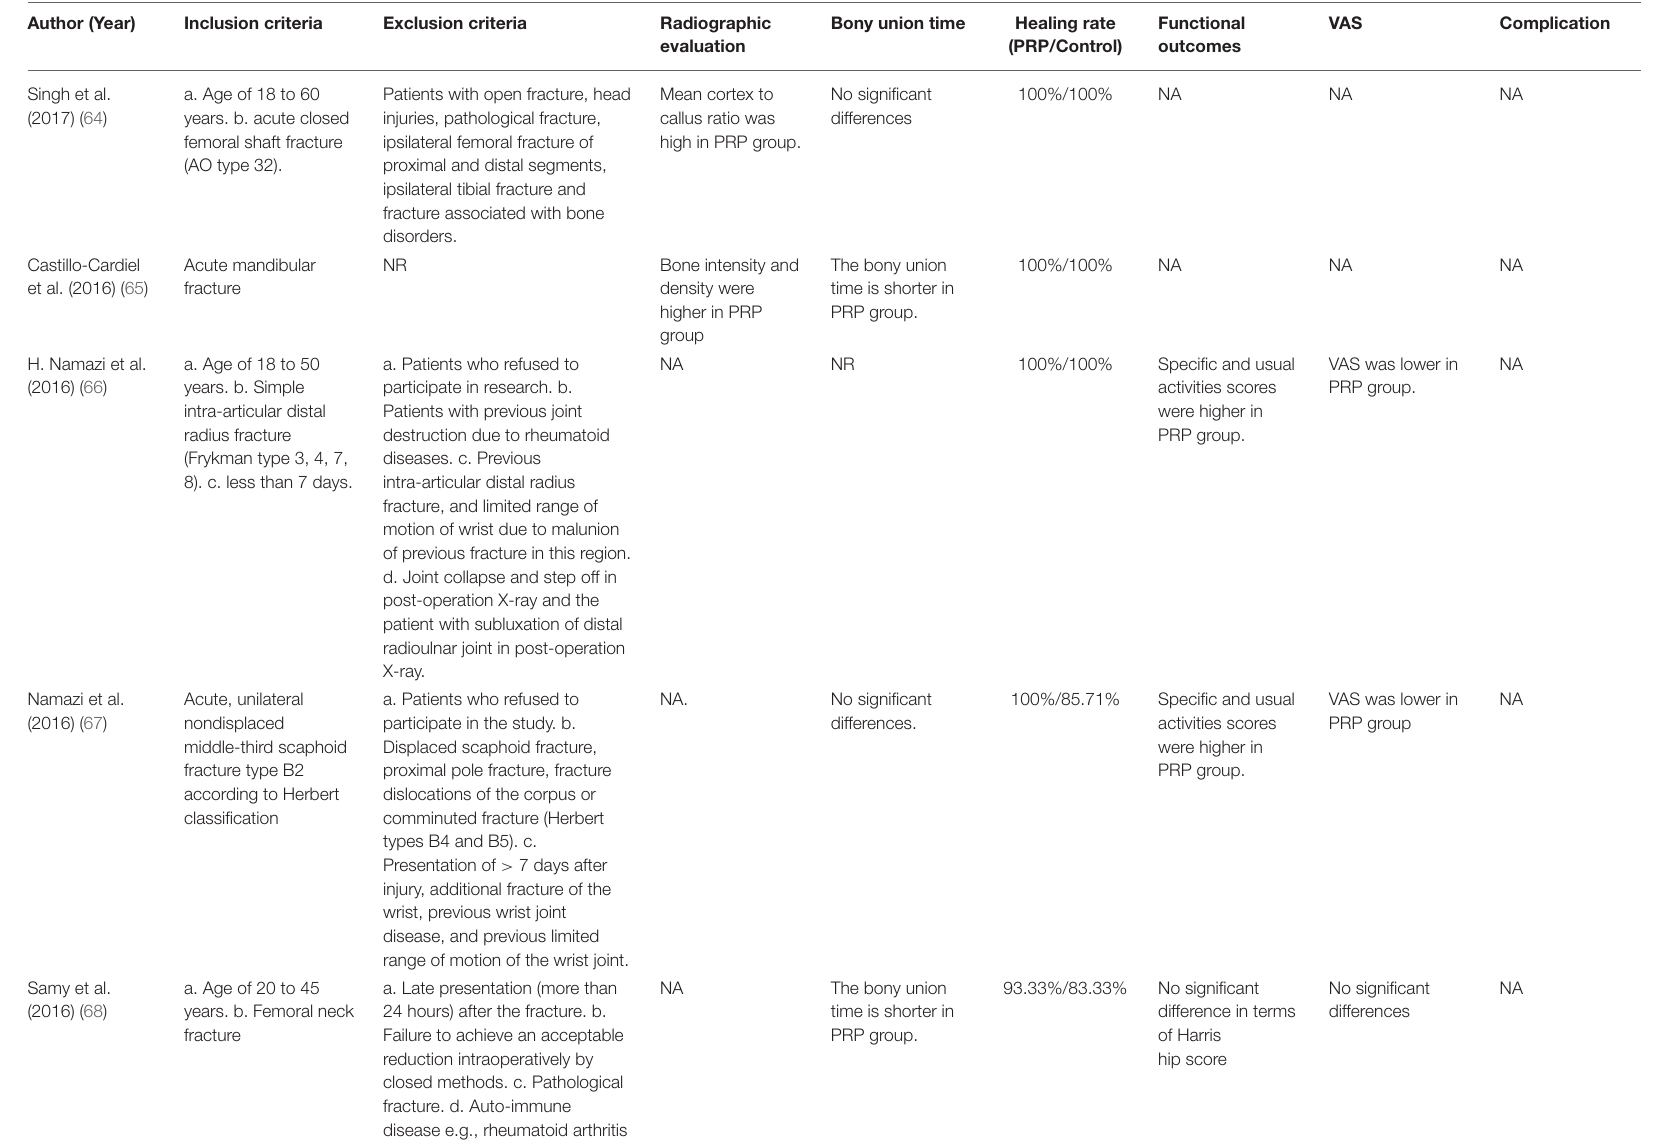
TABLE 6 | The inclusion criteria, exclusion criteria, and main results of clinical studies. Author